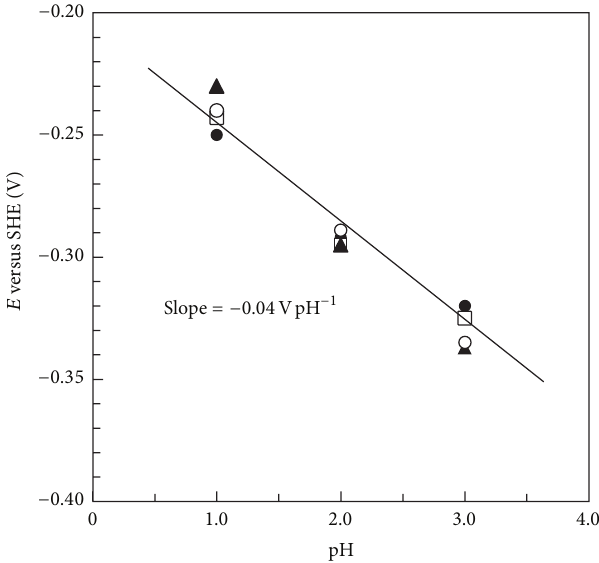
Figure 9: Relation between the corrosion potential, 𝐸 sulfuric acid solutions. The ratio of pearlite area, 𝑃 𝑟 : ( ∙ ) 0, ( ◻ ) 0.08, ( 󳵳 ) 0.29, and ( I )